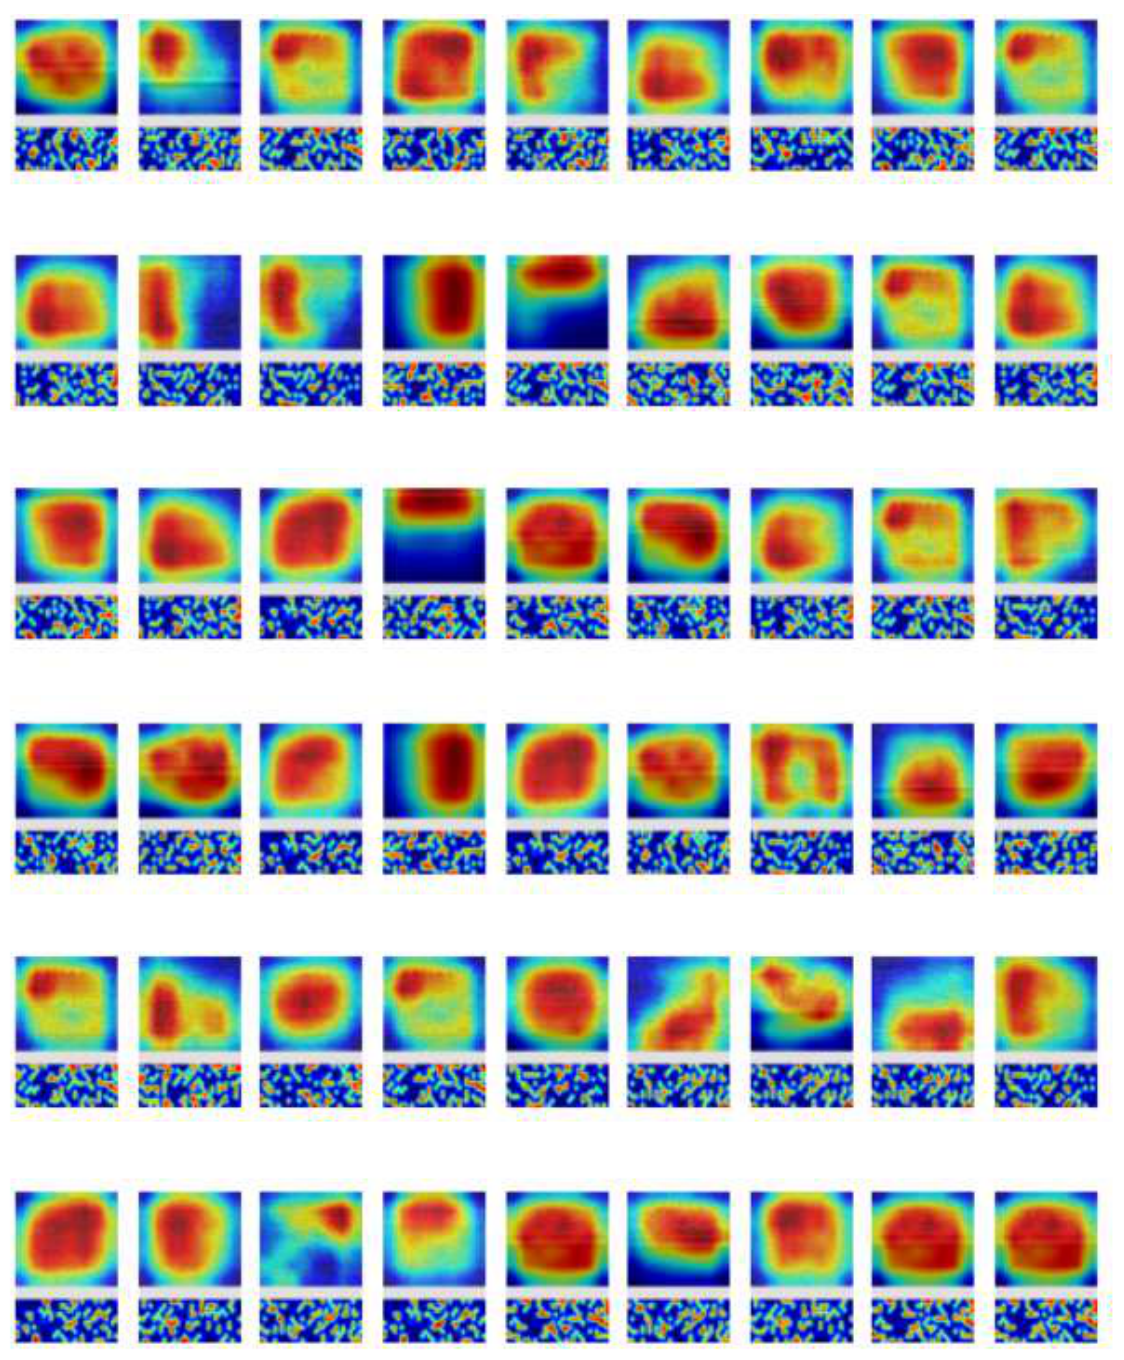
Figure 5. Heatmap display of class activation features for some samples.